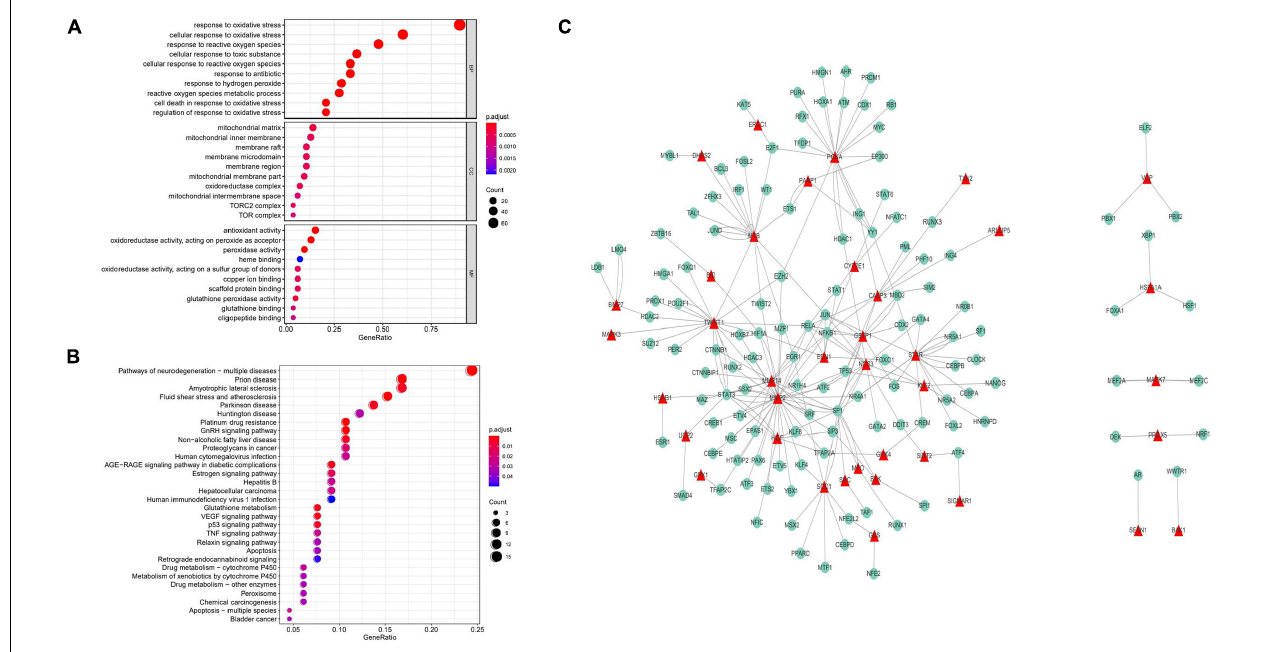
FIGURE 1 | GO enrichment analysis of prognostic genes. (A) In the GO rich concentration, there were responses to oxidative stress, cellular response to oxidative stress, response to ROS, response to engineering, cellular response to ROS, and other pathways. KEGG enrichment analysis of prognostic genes. (B) In the process of KEGG enrichment, there were pathways of neurodegeneration, apoptosis, MAPK signaling pathway, and other Pathways. (C) Transcriptional interaction network analysis. Thirty-eight prognostic genes had complex interactions with transcription